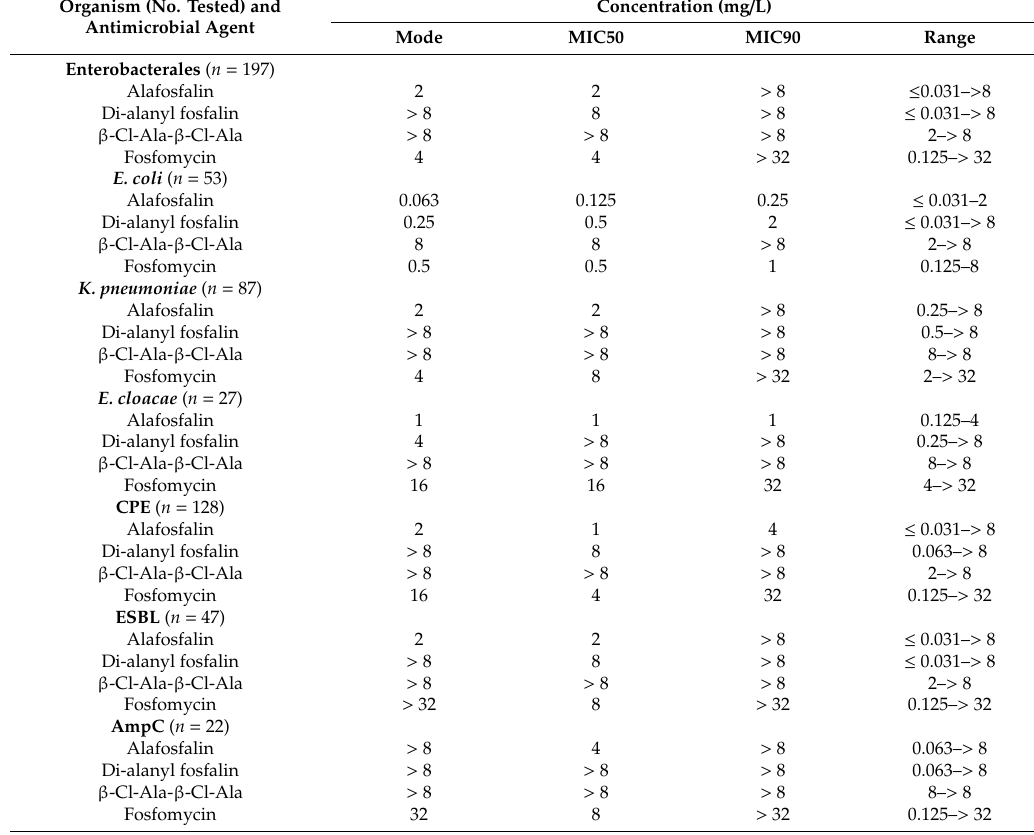
Table 1. Minimum inhibitory concentrations of various antimicrobial agents against groups of Gram-negative bacteria including isolates with defined resistance